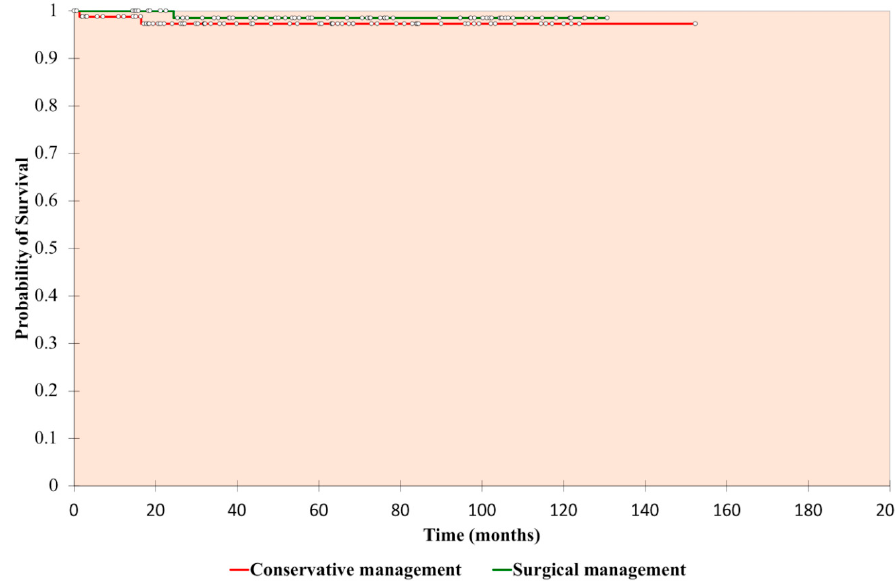
Figure 1. Kaplan-Meier analysis—renal cancer-specific survival of Bosniak III and IV cysts, surgical versus conservative management.